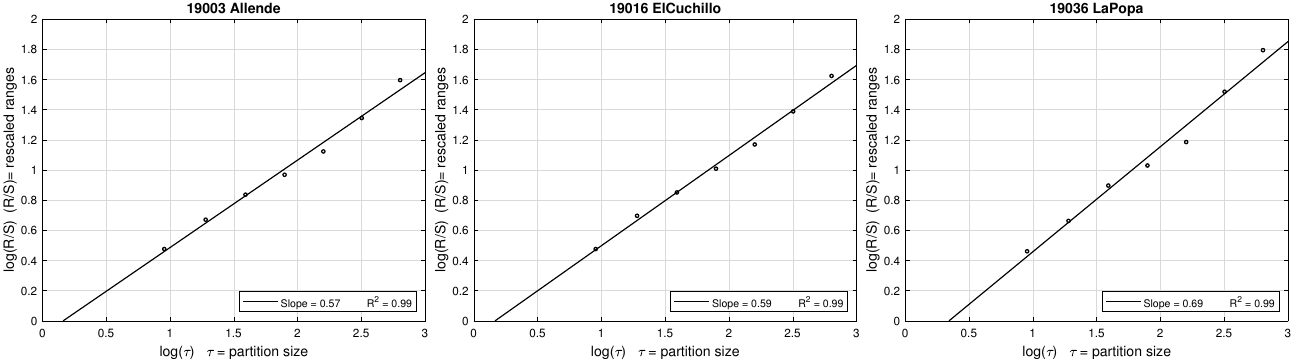
Figure 3. Calculation of Hrs by fitting the slope H from Equation (7), obtaining the coefficient of determination R 2 when considering d = 53, m = 12, which leads to seven data points to fit. In turn, Figure 4 shows the linear adjustments applied to Equation (10), in order to perform the calculation of HFD for the selected stations, by means of the least squares method. The value of the slope of the curve fitted is HFD .